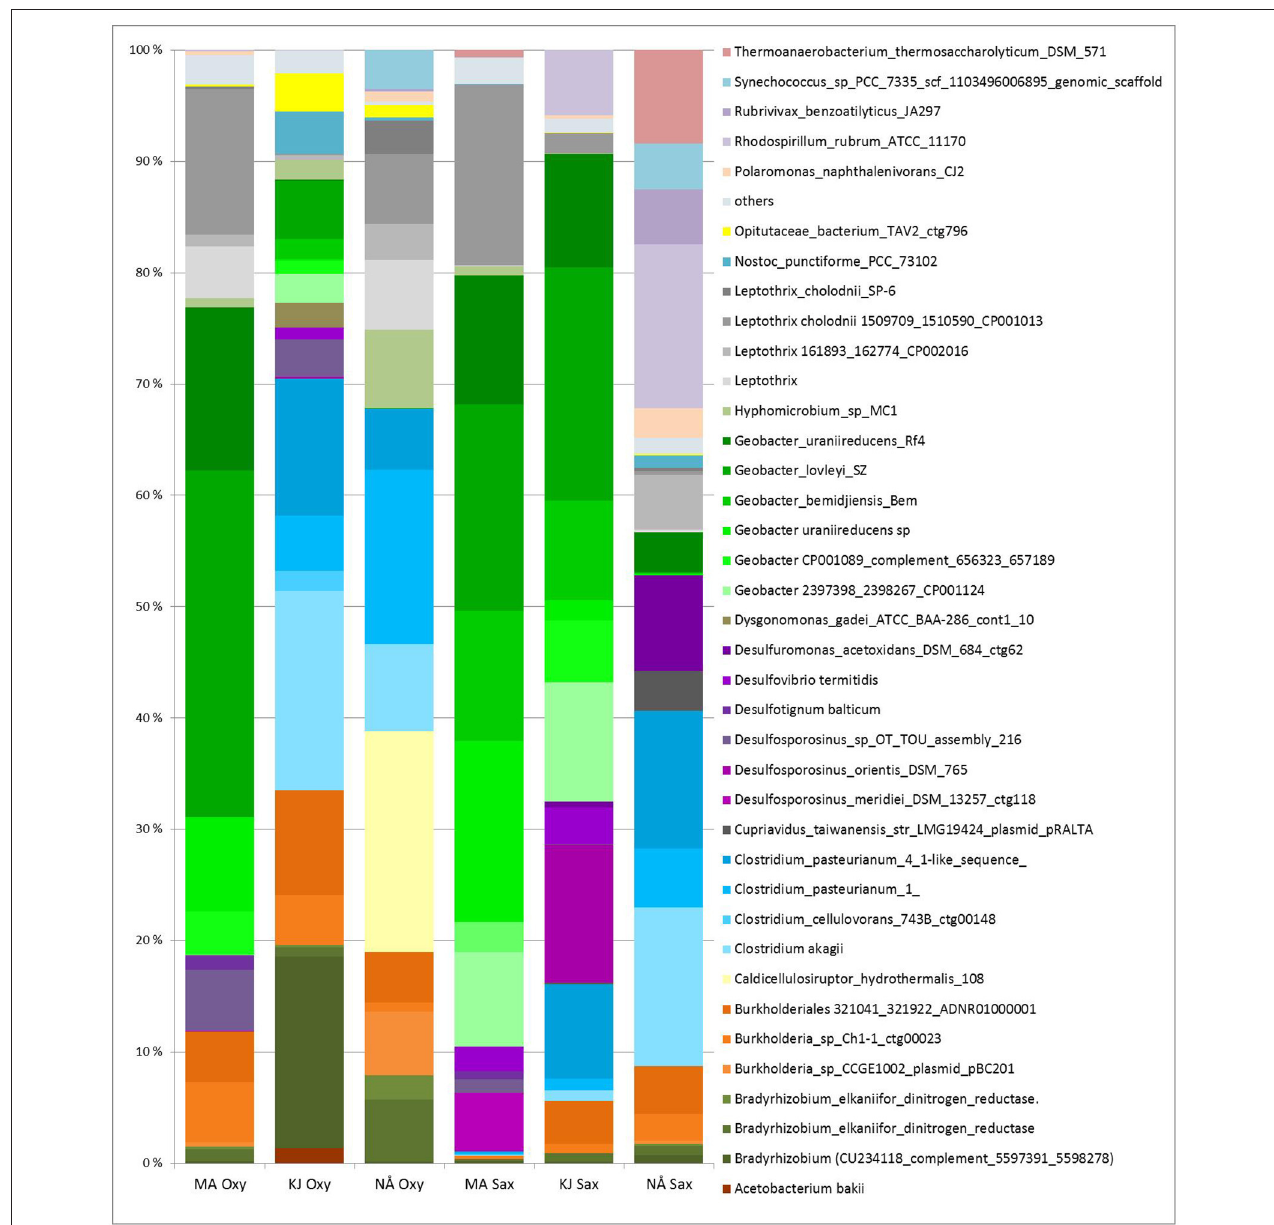
FIGURE 6 | Average relative abundances (four biological replicates) of PNFB in the endospheres of Oxyria digyna and S axifraga oppositifolia across all three regions. Only major PNFB OPUs (relative abundance above 1%) are indicated, OPUs with < 1% relative abundance are grouped together (“others”). Plant species: Oxy, O. digyna ; Sax, S. oppositifolia . Regions: MA, Mayrhofen; KJ, Kilpisjärvi; NÅ, Ny-Ålesund.